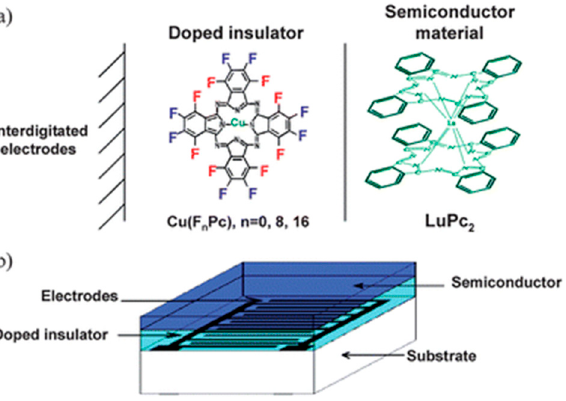
Figure 9. Architecture of the MSDI devices: ( a ) showing the molecular structure of the phthalocyanine materials; and ( b ) a schematic view of the organic-based device. Reprinted from [74] with permission from Royal Society of Chemistry.